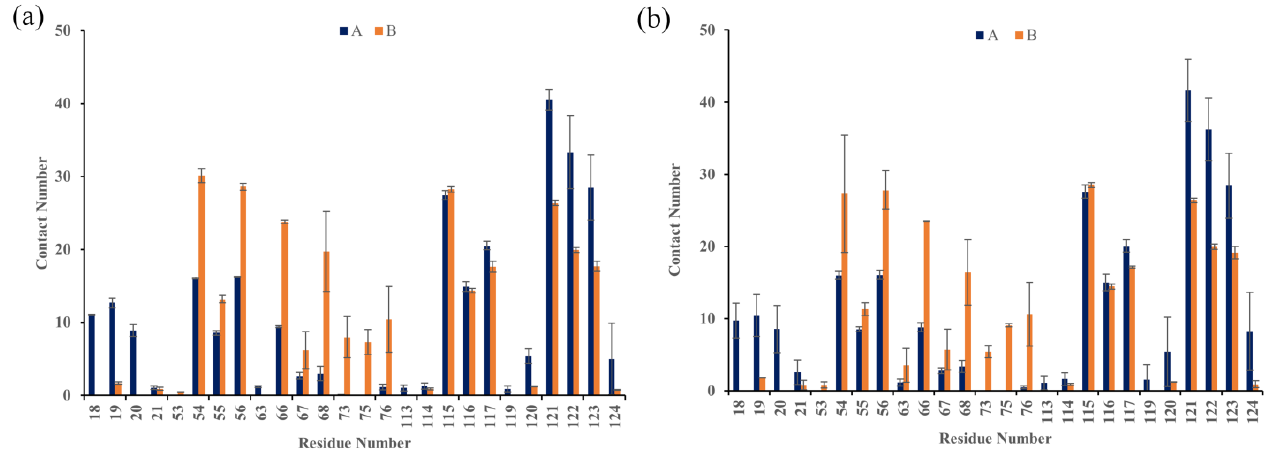
Figure 4. Contact numbers between BMS-200-related inhibitors and the PD-L1 dimer in the ( a ) S and ( b ) R systems. The error bars represent the standard deviations of 3 repeated